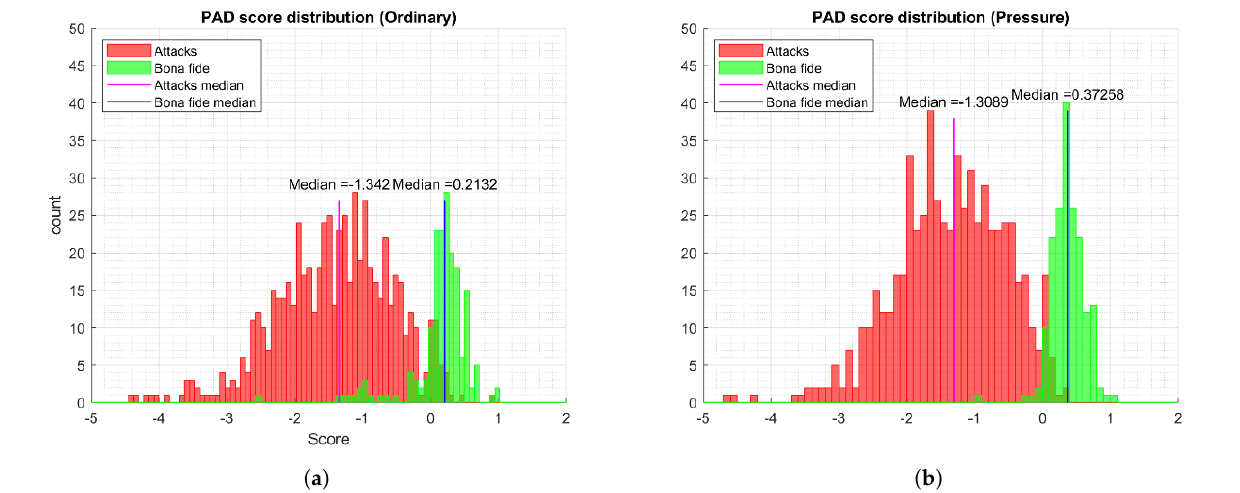
Figure 10. PAD scores distribution for the thermal sensor using GIST 3-D features.